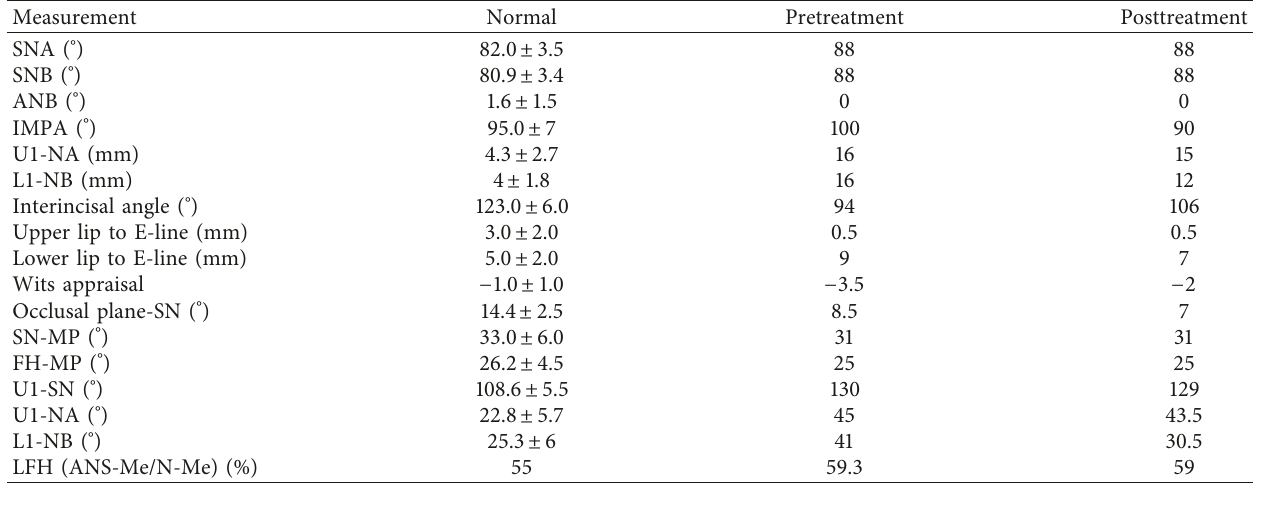
Table 1: Cephalometric measurements.